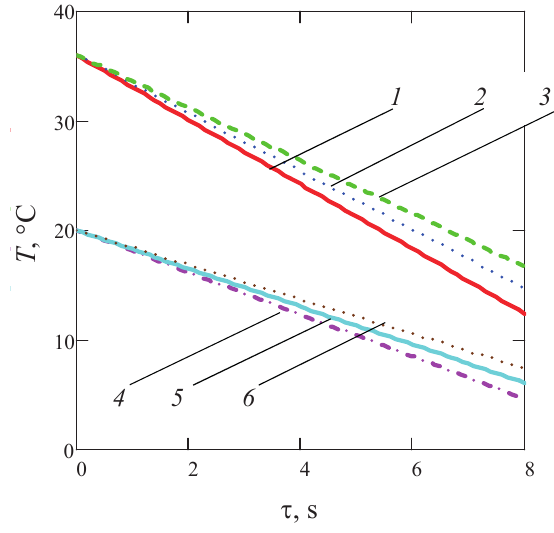
temperature of liquid and the axial coordinate z for partial